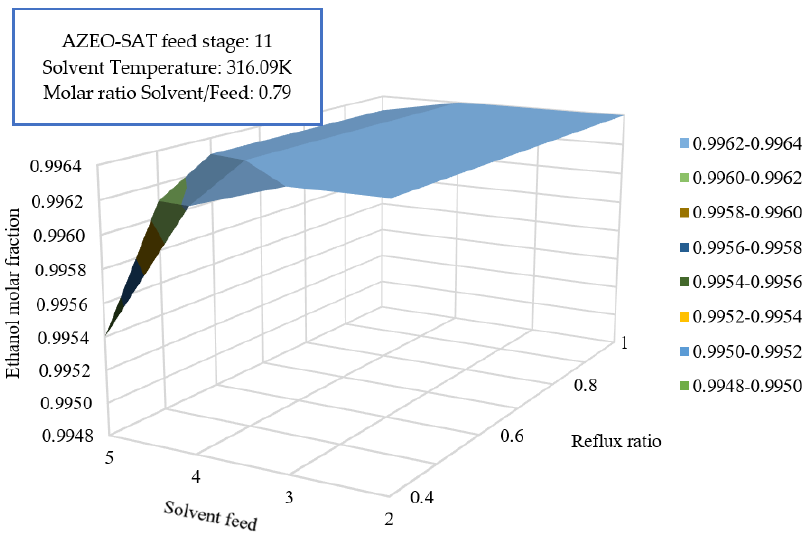
Figure 6. Reflux ratio and solvent feed variation on ethanol